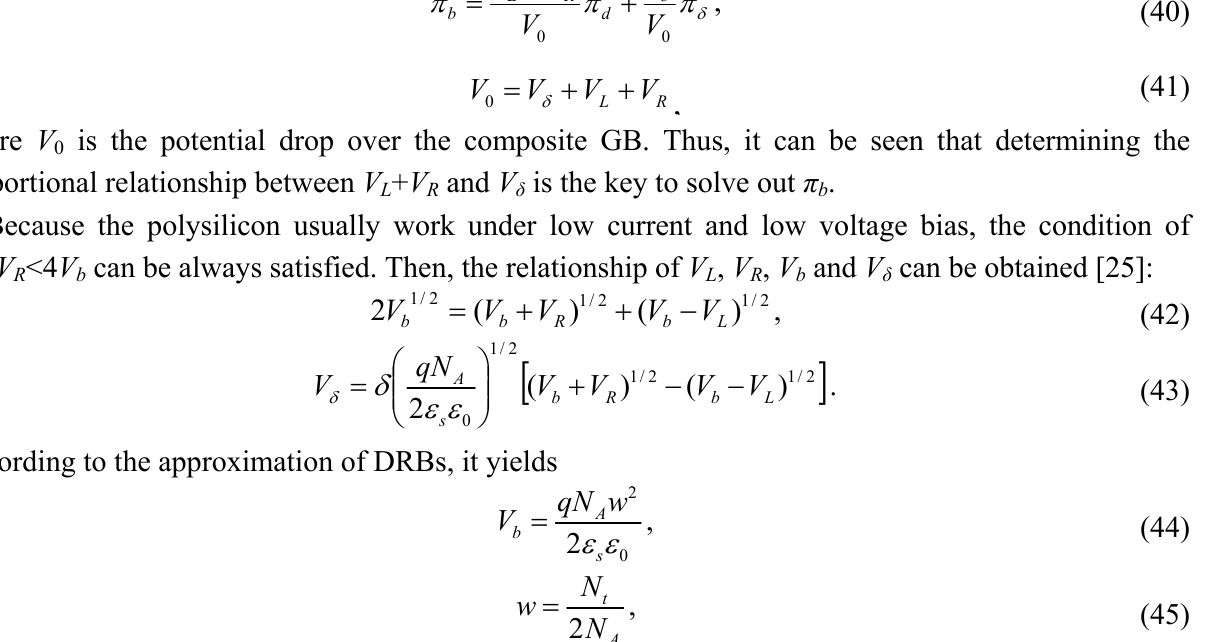
normalized to V δ